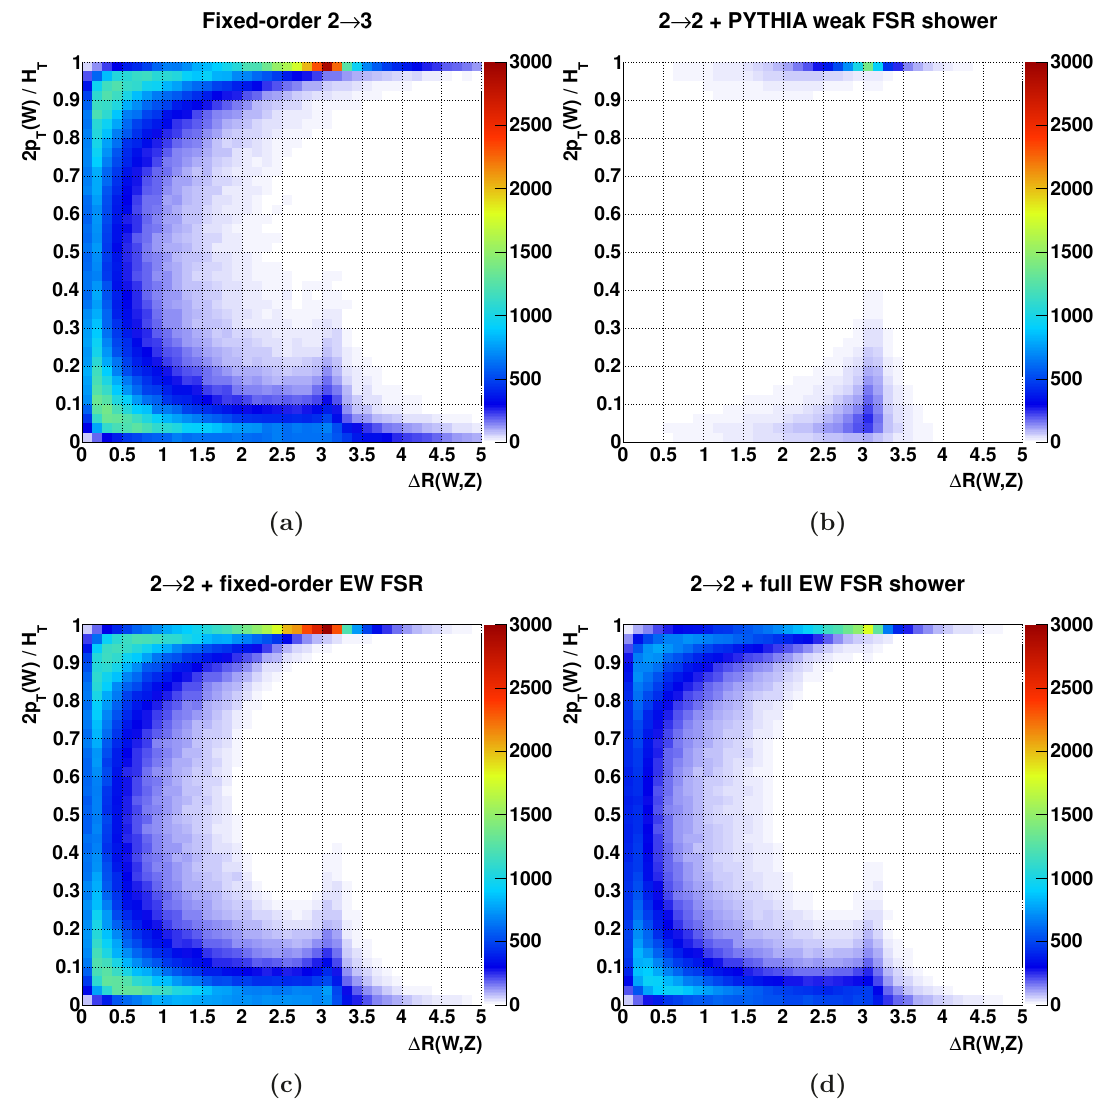
Figure 4. Event population for exclusive WZ + j production in the plane of 2 p T ( W ) /H T versus ∆ R ( W, Z ) with p T ( j ) 3 TeV at a 100 TeV proton collider. (a) 2 3 fixed-order WZj production ≥ → generated with MadGraph ; (b) 2 2 dressed with the PYTHIA weak shower, which includes only → q V q splittings; (c) 2 2 Wj and Zj production dressed with fixed-order FSR splitting → → functions; (d) 2 2 dressed with the full EW FSR shower, including all collinear final-state → Sudakov effects. QCD showering is not incorporated. An integrated luminosity of 10 ab − 1 is used for